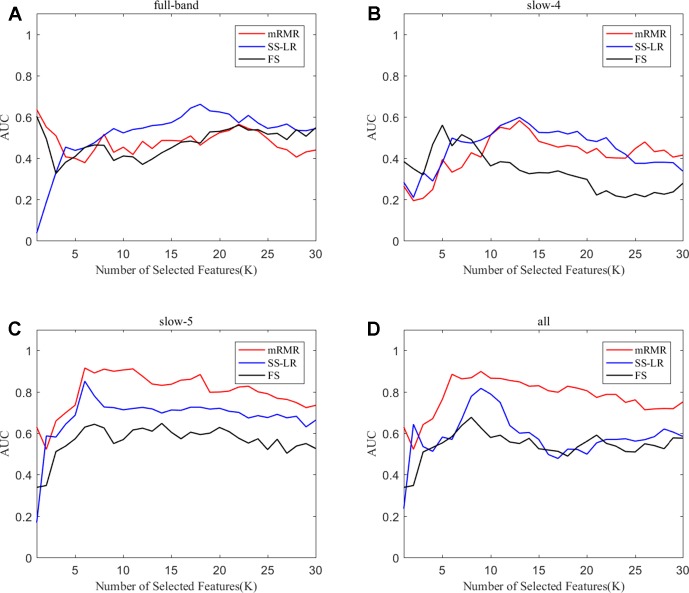
Subgraphs (A), (B), (C), and (D) represent AUC curves with the number of features K of full-band, slow-4, slow-5, and all band.